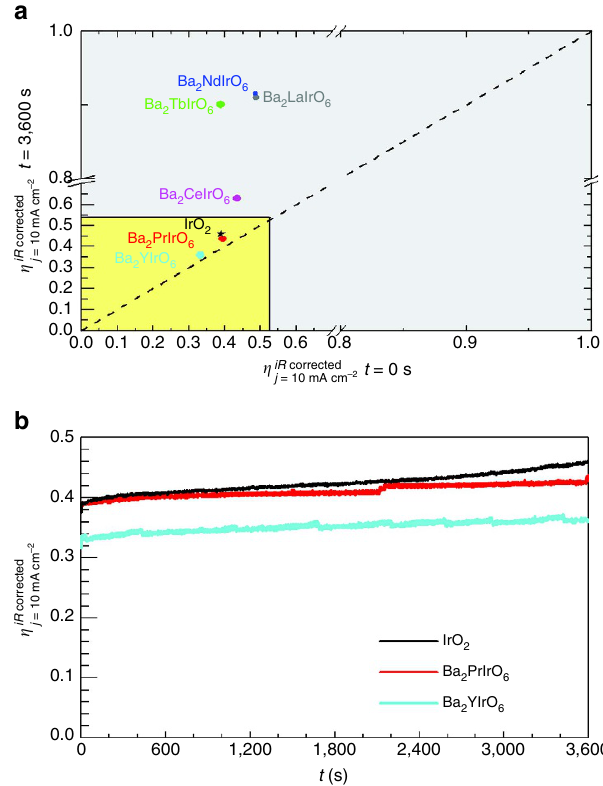
Figure 2 | Stability of the double perovskites under OER conditions. ( a ) OER overpotential measured on the Ir DPs after 1h of galvanostatic electrolysis plotted as a function of the initial overpotential. ( b ) Evolution of the OER overpotential on Ba 2 PrIrO 6 , Ba 2 YIrO 6 DPs and IrO 2 nanoparticles during 1h of galvanostatic